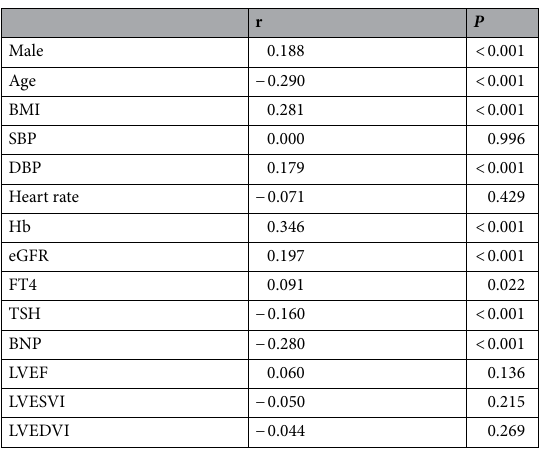
Table 4. Spearman’s rank correlation coefficients between the FT3 level and various clinical factors (n = 625). FT3, free triiodothyronine; BMI, body mass index; SBP, systolic blood pressure; DBP, diastolic blood pressure; Hb, hemoglobin; eGFR, estimated glomerular filtration rate; FT4, free thyroxine; TSH, thyroid-stimulating hormone; BNP, B-type natriuretic peptide; LVEF, left ventricular ejection fraction; LVESVI, left ventricular end-systolic volume index; LVEDVI, left ventricular end-diastolic volume index.